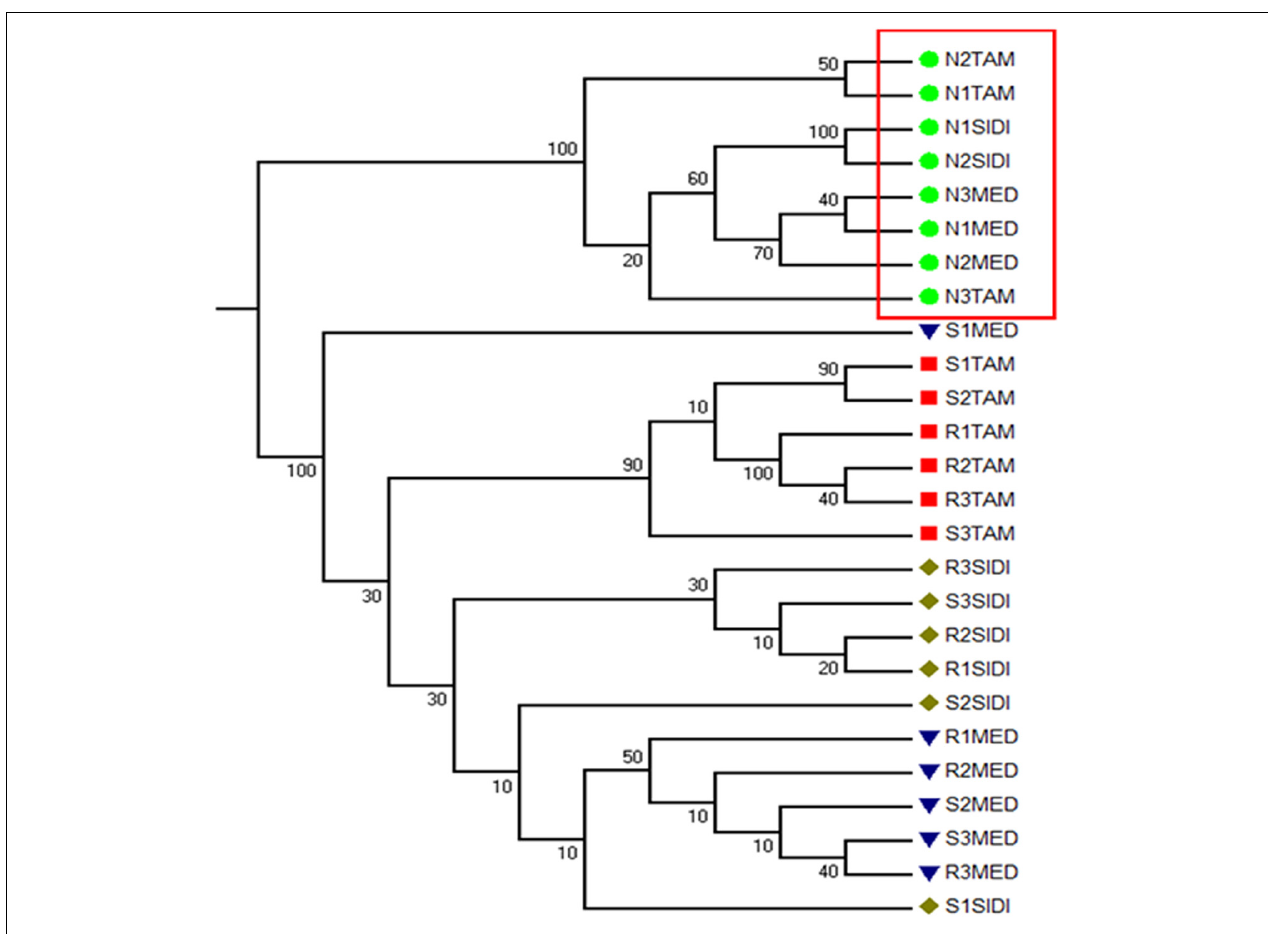
FIGURE 4 | Unweighted pair group method with Arithmetic Mean (UPGMA) Consensus Tree. The tree was constructed from the rarefied unweighted UniFrac distance Matrix. The consensus tree was built by creating 100 trees from 100 randomly subsampled reads from each sample. The numbers on the nodes represent the percentage of the 100 trees that conformed to this configuration. The red box outlines that all nodule samples form one cluster on the tree. The other clades on the tree show that the soil and rhizosphere communities cluster mostly by sampling site.